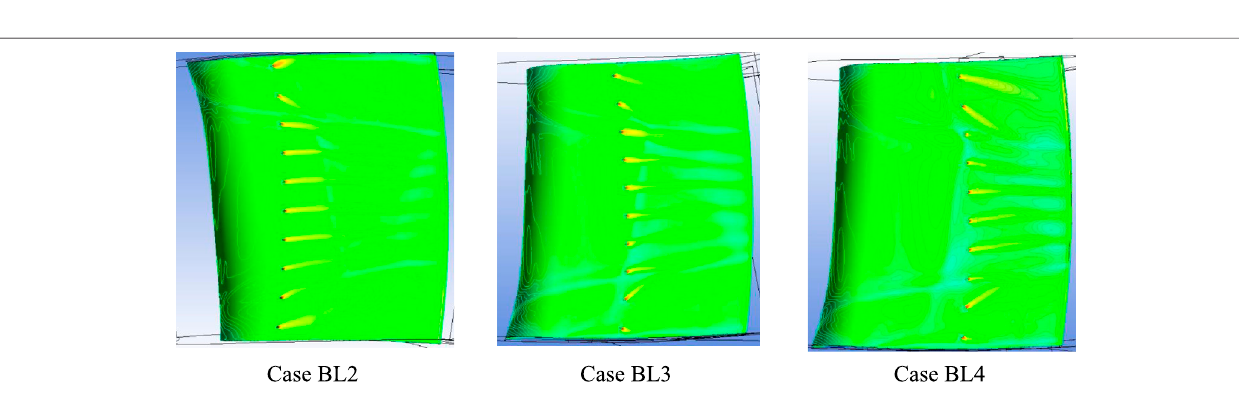
Frontiers in Energy Research |